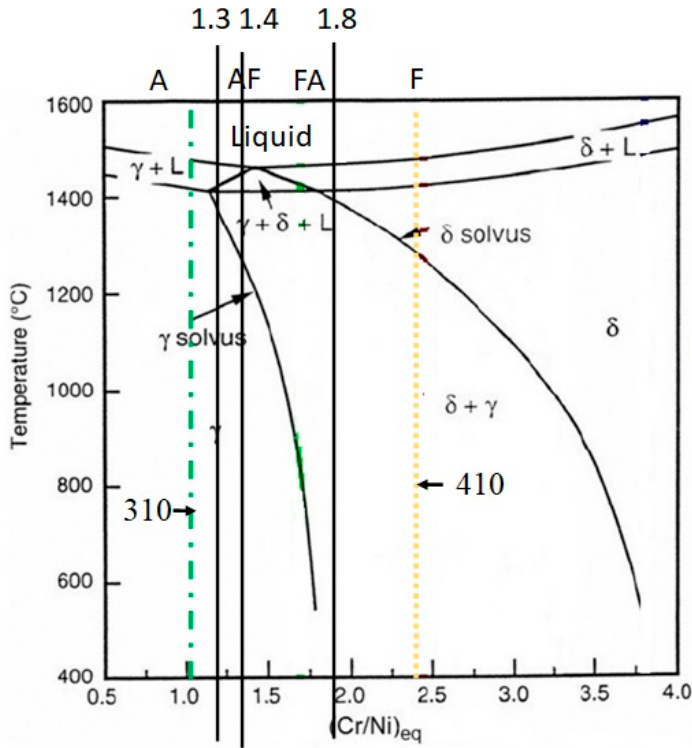
Figure 3. Schaeffler diagram.